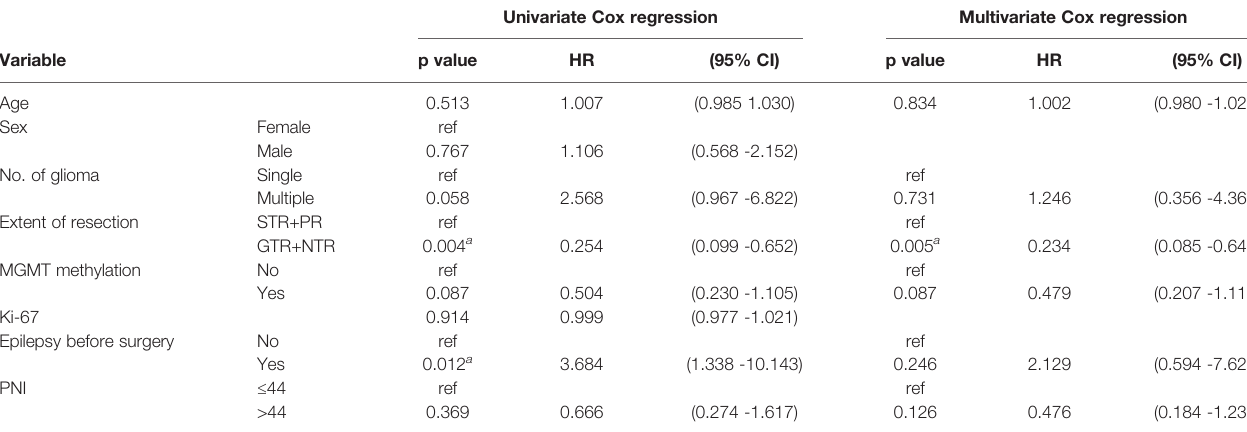
TABLE 3 | Univariate and multivariate Cox regression analyses for overall survival in the IDH wide-type IV glioma